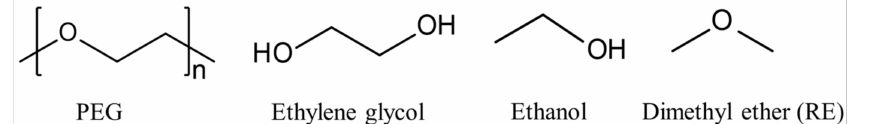
Figure 1. Polyethylene glycol (PEG) and different choices of small molecules with a structural motif of the repeating element of